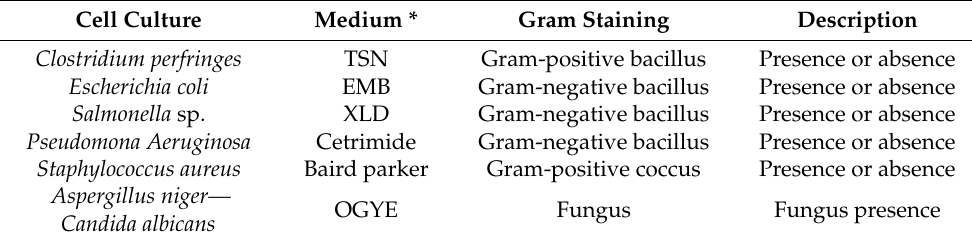
Table 1. Microbiological evaluation of specific